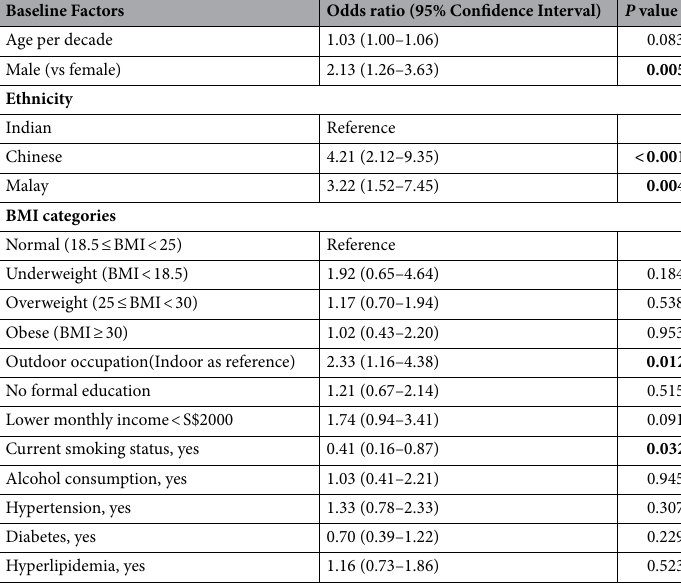
Table 4. Multivariable logistic regression analysis on the association between baseline factors and incident pterygium. BMI body mass index.